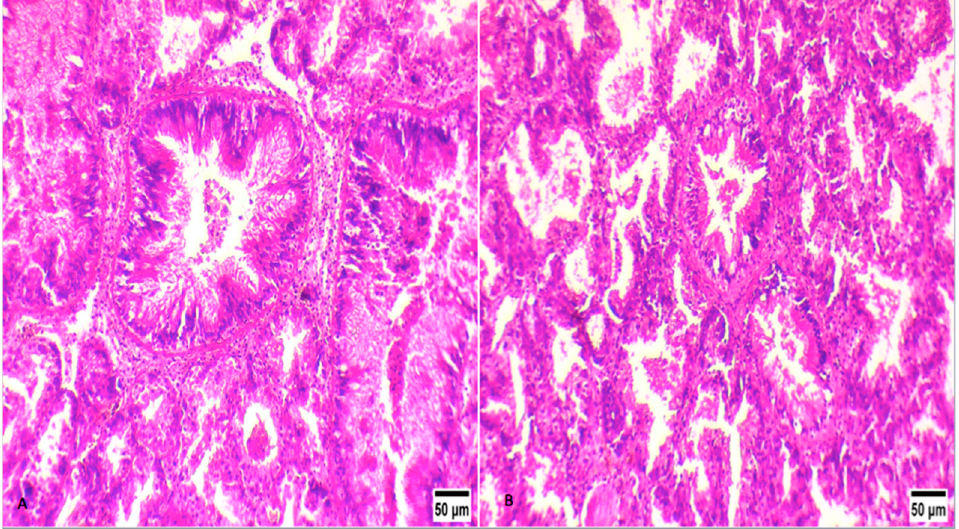
Figure 4. Histological display of the digestive gland of two different P. nobilis specimens. ( A ) Digestive gland of fan mussel infected with Mycobacterium sp., H. pinnae , and V. splendidus . ( B ) Digestive gland of fan mussel infected only with Mycobacterium sp. and V. splendidus . Both exhibit heavy inflammation responses and heavy lesions in the connective tissue of the digestive gland. A degenerative process was also indicated in the epithelium of the digestive tubules of both specimens, regardless of the presence of H. pinnae .